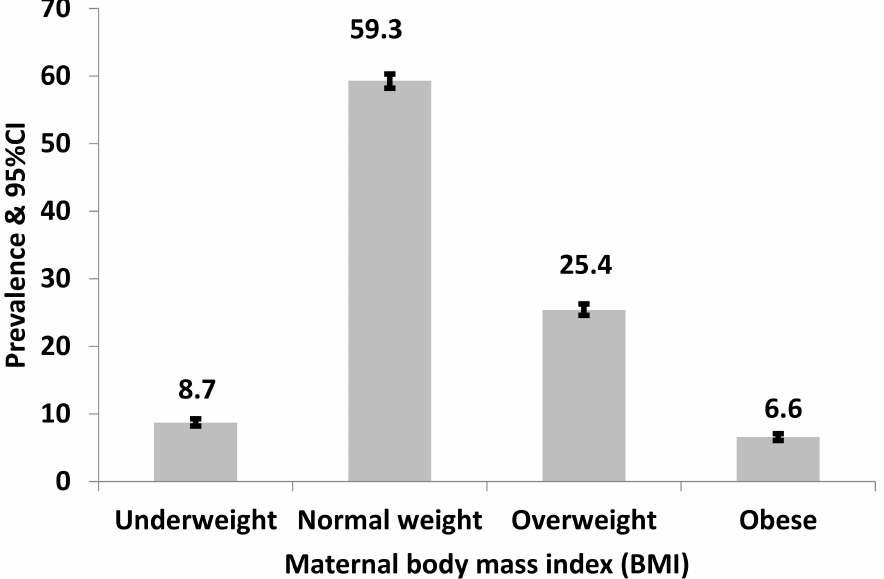
Figure 2. Prevalence and 95% confidence intervals of body mass index categories among women aged 15–49 years in Bangladesh (2004 to